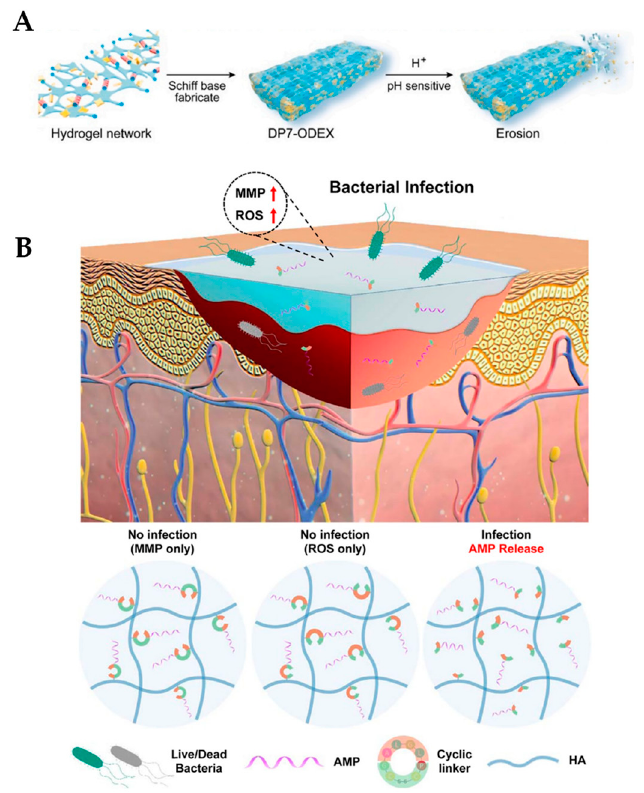
Figure 3. Release mechanisms for AMP-loaded hydrogels. ( A ) Structure of DP7-ODEX hydrogel. The hydrogel network is fabricated by Schiff base chemistry, forming DP7-ODEX. When exposed to low pH, the hydrogel erodes, releasing antimicrobial contents. Reprinted with permission from Ref.